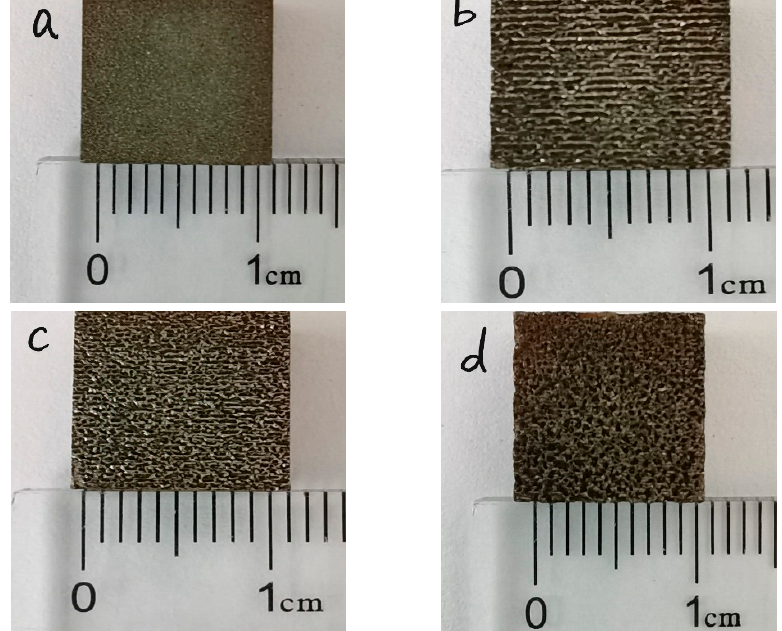
Figure 4. The macro morphology of coatings after laser re-melting with different degrees of power: ( a ) 1#; ( b ) 2#; ( c ) 3#; ( d ) 4#.